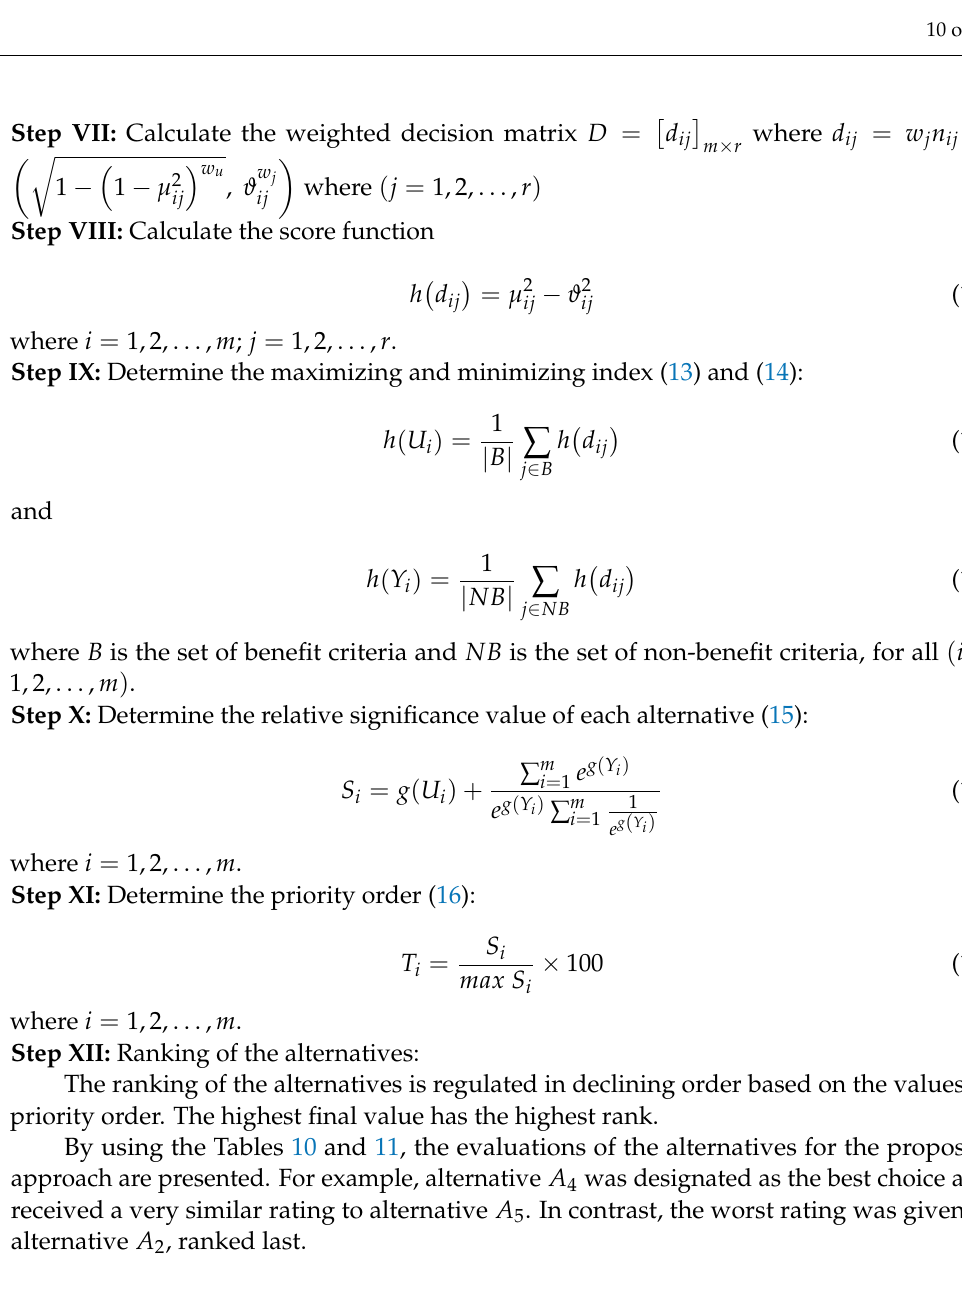
Table 10. The score function for alternatives.